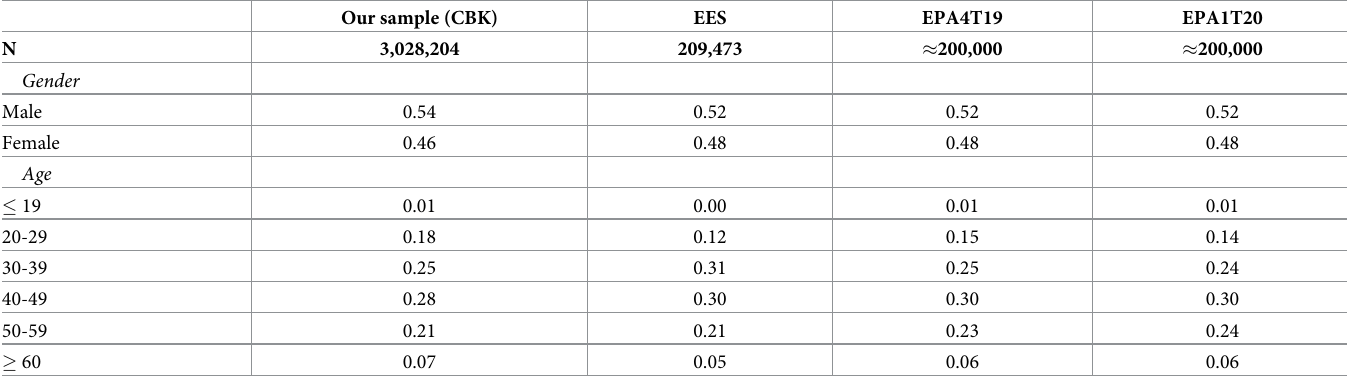
Table 1. Check our data versus labor